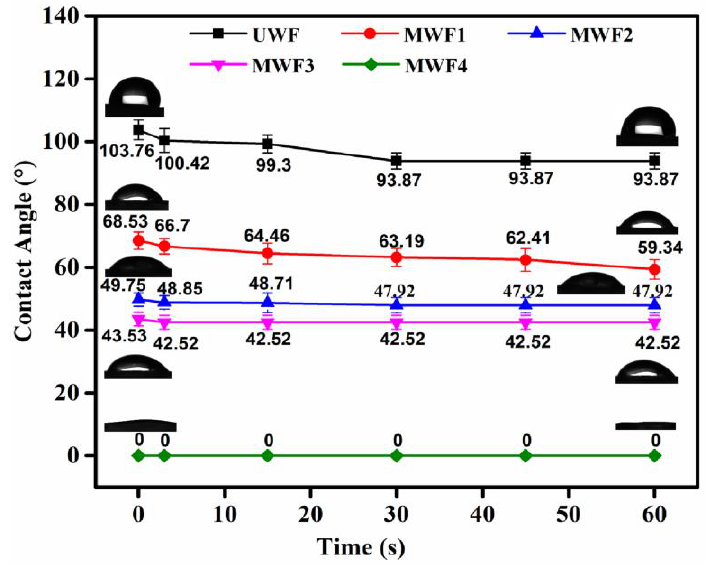
Figure 7. Contact angles of the UWF and MWFs .